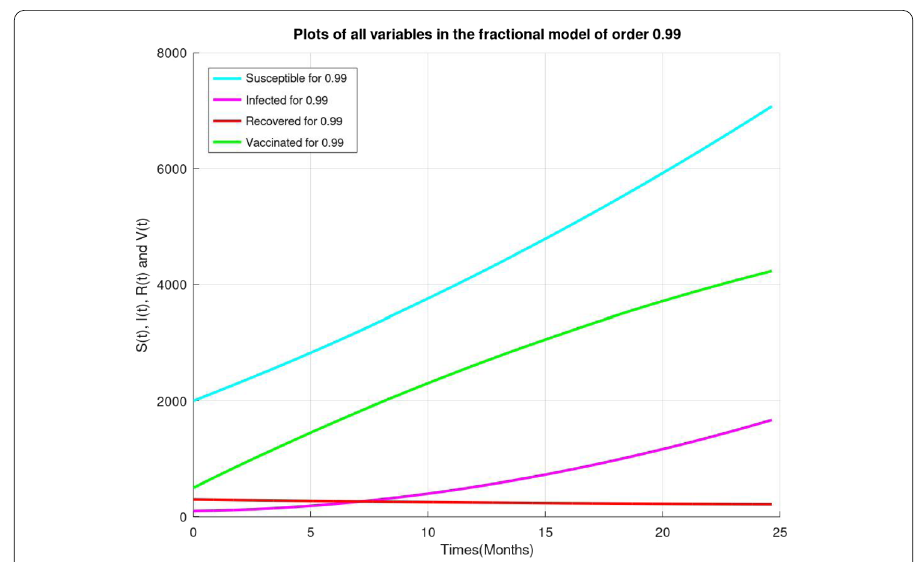
Figure 1 An illustration of the total number of each class of animal populations S ( t ), I ( t ), R ( t ), and V ( t ) for order (cid:2) = 0.99